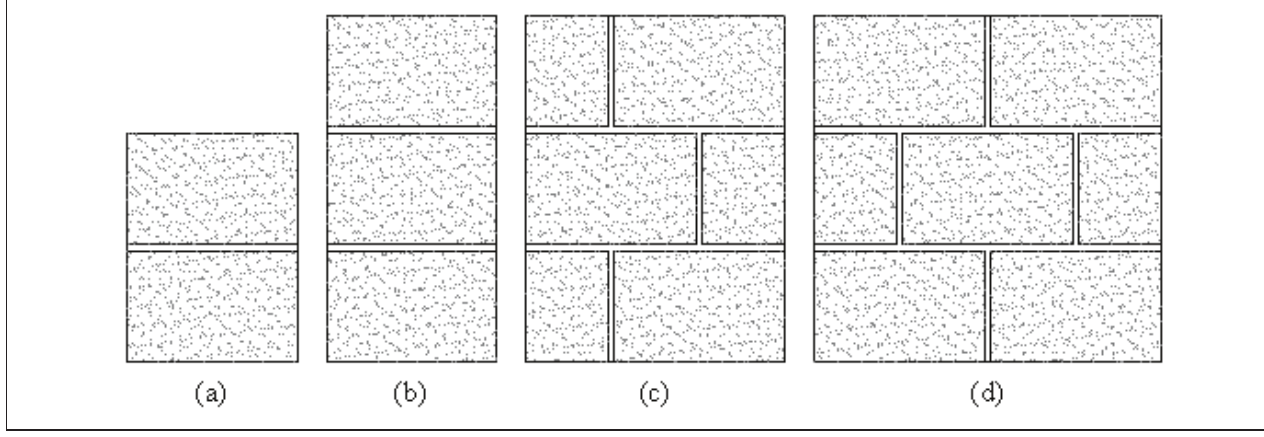
Figure 1 – Arrangement of the test specimens under study: (a) and (b) two (PR2B) and three block prisms (PR3B), respectively, and (c) and (d) stretcher bond prisms (PRC1½B) and (PRC2B),